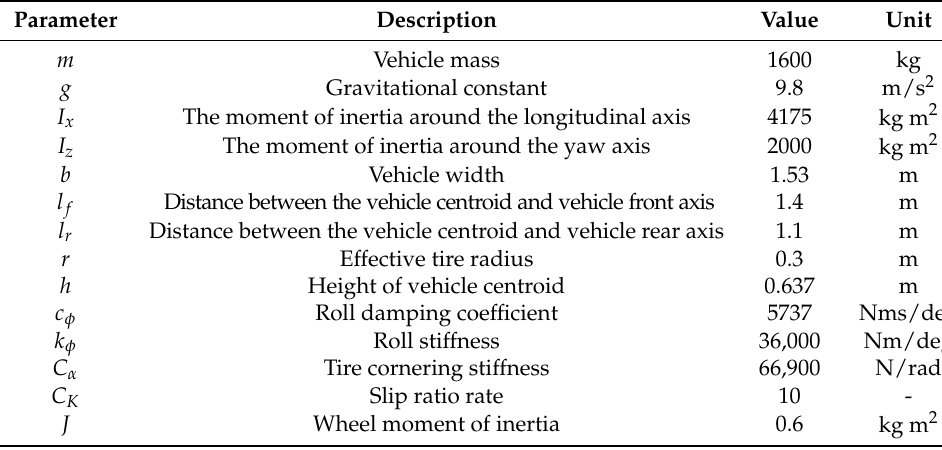
Table 6. Model parameters and